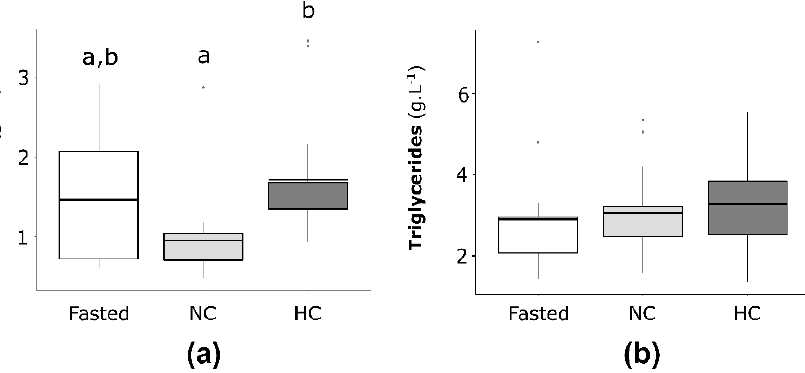
Figure 2. ( a ) Plasma glucose and ( b ) triglycerides concentrations of mature female rainbow trout fasted 15 days (Fasted, white), fed with NC diet (non-carbohydrate diet, grey) and fed with HC diet (high-carbohydrate diet, dark grey). Data ( n = 15 fish per condition) were analysed with either one- way ANOVA when the conditions of application were respected or the Kruskal-Wallis test, fol- lowed by a post hoc Tukey’s test in case of significant differences ( p < 0.05, indicated with different letters).